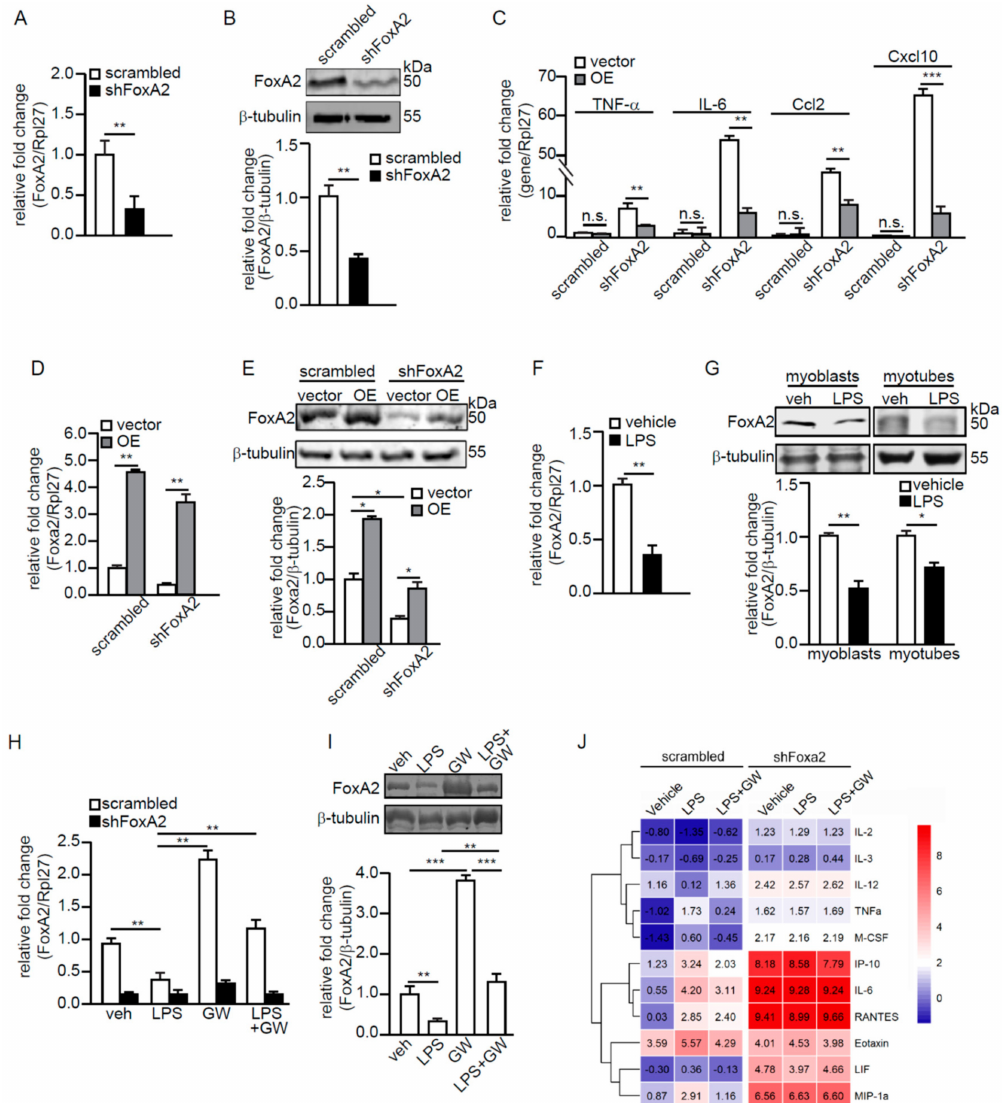
Figure 4. FoxA2 attenuates LPS-induced inflammation in C2C12 myoblasts. ( A , B ) Relative fold change in FoxA2 mRNA ( A ) and protein ( B ) levels in scrambled or shFoxa2-knockdown C2C12 cells; ( C ) Relative fold change in mRNA levels of selected proinflammatory genes in shFoxA2-knockdown and scrambled C2C12 cells transfected with empty vector (vehicle) or expression vector containing FoxA2 (OE) cDNA; ( D – I ) Relative fold change in FoxA2 mRNA ( D , F , H ) and protein ( E , G , I ) levels in shFoxA2-knockdown, scrambled, and FoxA2-overexpressing C2C12 cells ( D , E ), in LPS- (100 ng / mL) or vehicle-treated C2C12 cells ( F , G ) and in the presence or absence of GW501516 (GW) ( H , I ); ( J ) Cytokine concentrations in conditioned medium of scrambled and shFoxA2-knockdown cells subjected to indicated treatments for 24 h. Heatmap shows the log 2 value of the concentrations. Representative immunoblots of FoxA2 are shown. B-tubulin serves as a loading control is from the same samples. Values are the mean + SD from 3 independent experiments. * p < 0.05; ** p < 0.01; *** p < 0.0001; and n.s., not